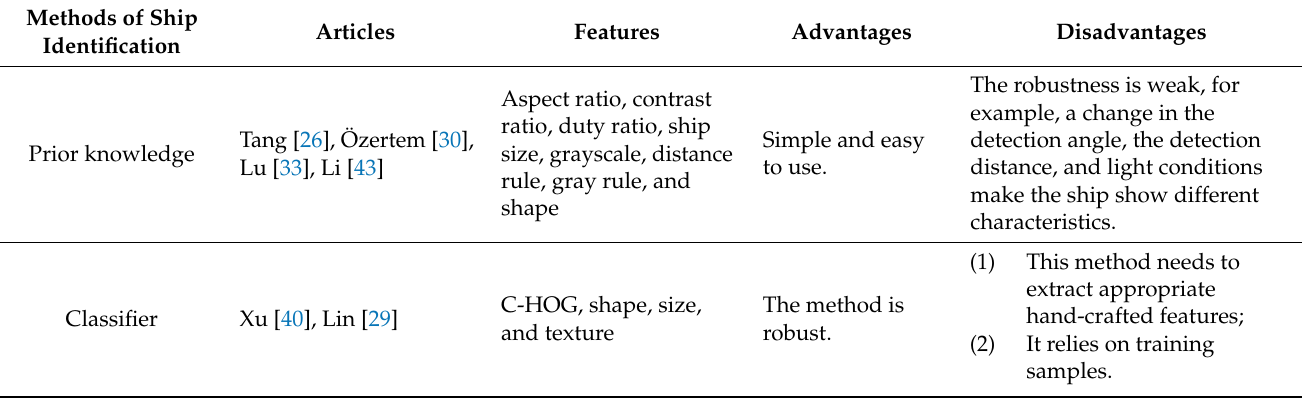
Table 5. Summary of the various ship identification methods.